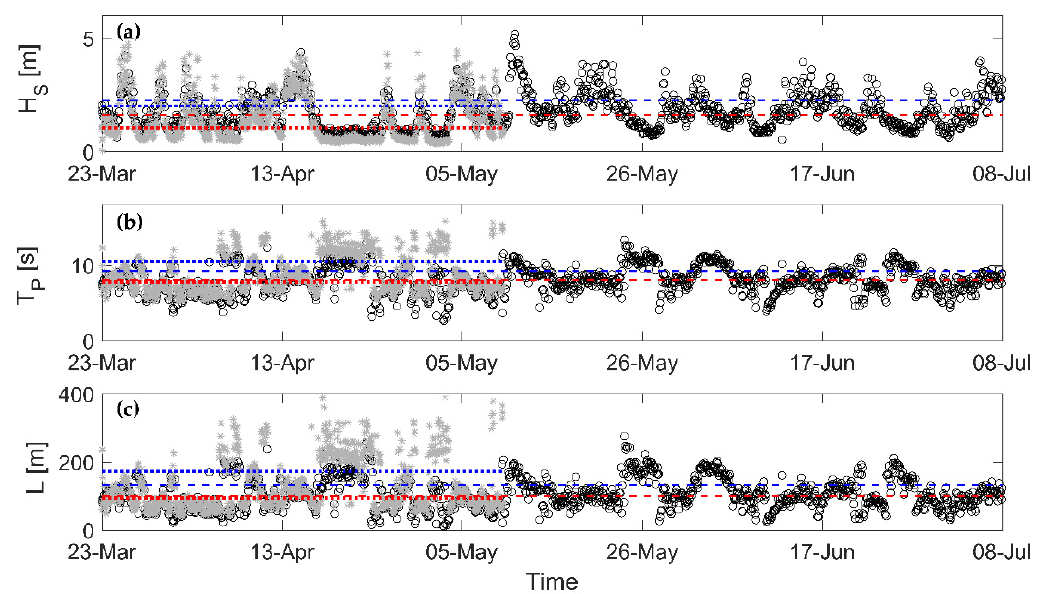
Figure 2. Time-series for ( a ) significant wave height, ( b ) peak wave period, and ( c ) estimated wavelength. Red and blue lines indicate 50th and 75th percentiles respectively. Black circles and dashed lines correspond to instrument CWTb1 and grey stars and dotted lines, to instrument CW4.